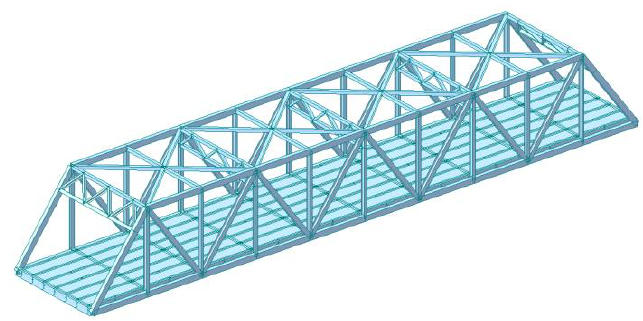
Figure 2. Damage detection flow chart of steel truss bridges.